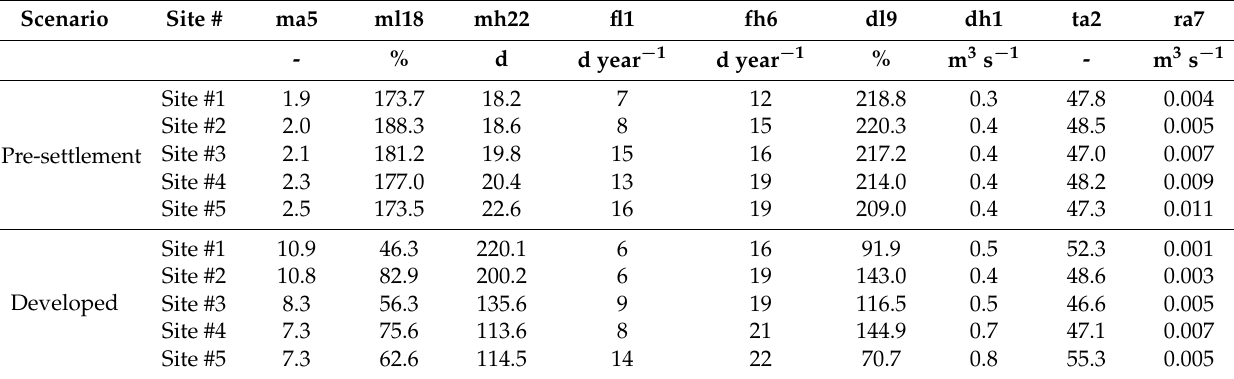
Table 7. Values of a minimum subset of hydrologic indices represent key elements of simulated pre-settlement and developed flow regimes at five gauging sites in Hinkson Creek, MO, USA. Definitions of hydrologic indices are shown in Table